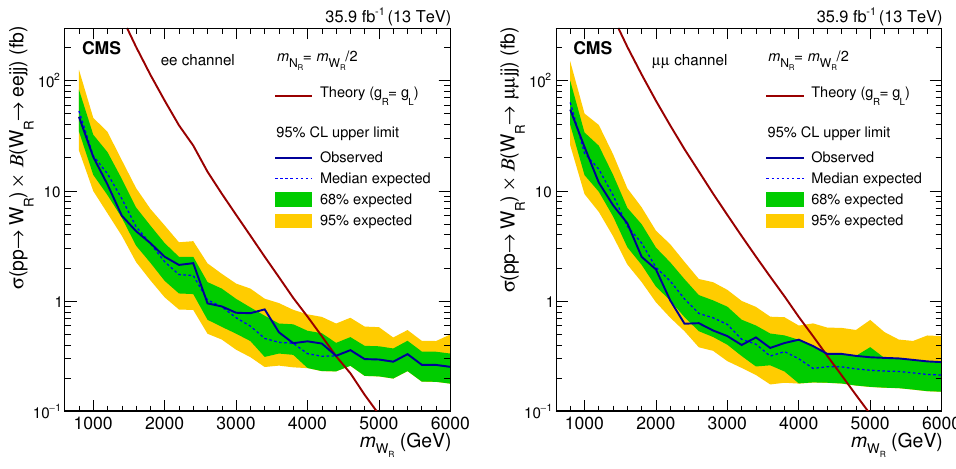
Figure 5 . Expected and observed 95% CL upper limits on the product of (cid:27) (pp ! W R ) and branching fraction B (W R ! ‘‘ jj) for the electron channel on the left and for the muon channel on the right. The inner (green) band and the outer (yellow) band indicate the expected 68% and 95% CL exclusion